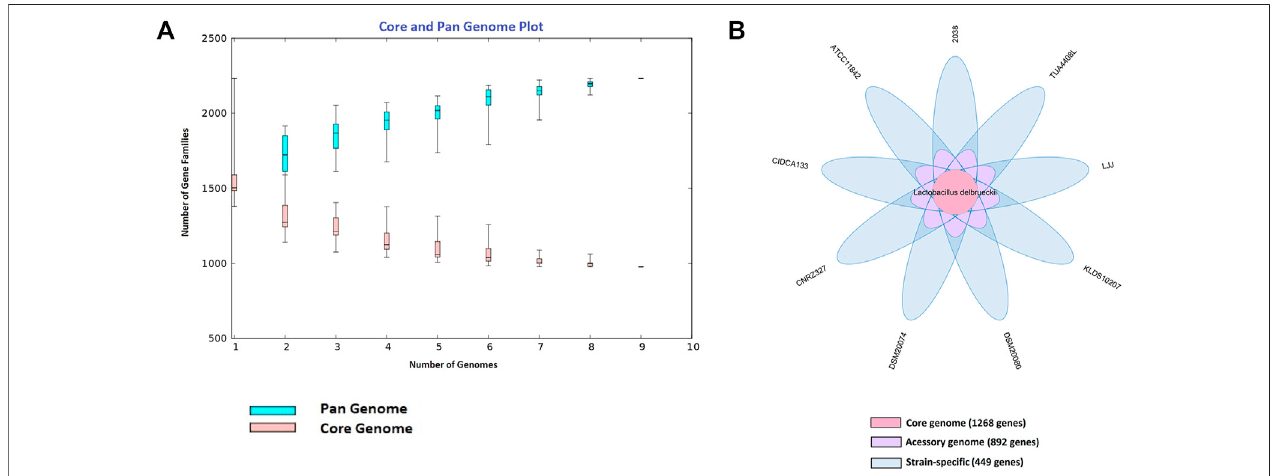
FIGURE 1 | Pan-genome of probiotics L. delbrueckii strains. (A) Curve development of pan (blue color) and core (salmon color) genome ( α = 0.83). The number of gene familiesisplottedinfunctionofthegenomenumber. (B) Venndiagram illustrating thecore-genome size(center part), accessory genomes(around thecenter), and unique genes for each strain (extreme